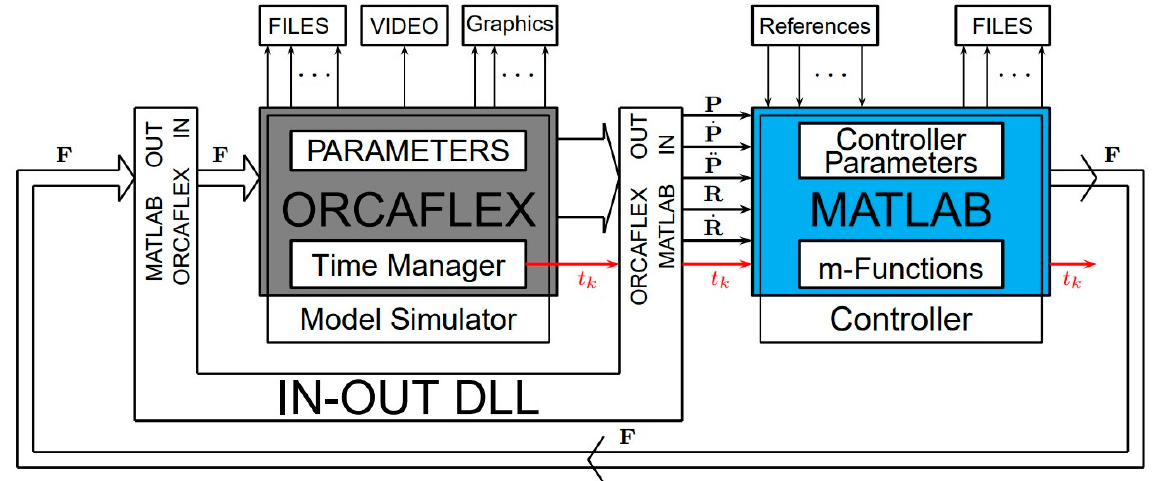
Figure 11. Scheme of the signals flow between OrcaFlex–Matlab.